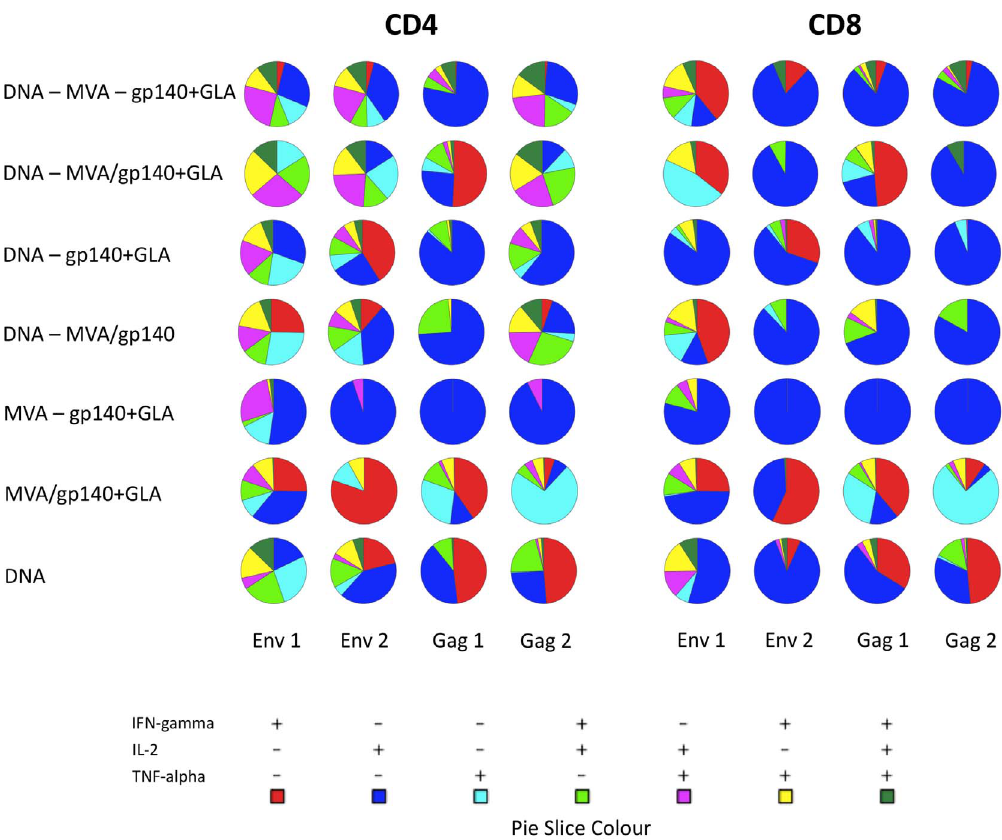
Figure 5. Polyfunctional cytokine responses of peptide pool stimulated splenocytes. Cells from each animal were stimulated with each different peptide pool for 6 hours at 37 u C in the presence of a golgi secretion inhibitor. CD4 + or CD8 + T cell populations were gated and single, double or triple cytokine expressing cell percentage enumerated. The percentage cytokine expression of each animal was averaged within the group and is expressed as a pie-chart of relative proportions of the total cytokine expressing cell population. Pie slice colour key indicates the particular cytokine(s) expressed.